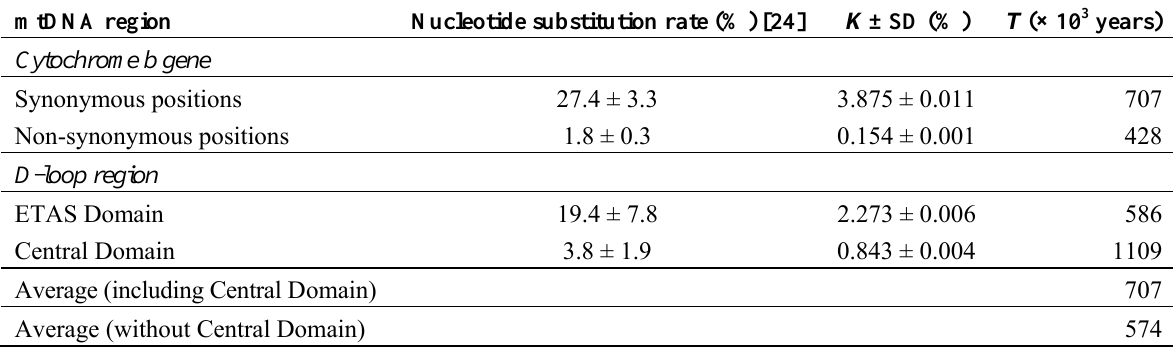
Table 2. Net-average genetic distances between clades ( K ) and the time period that had passed since the separation of the two clades ( T